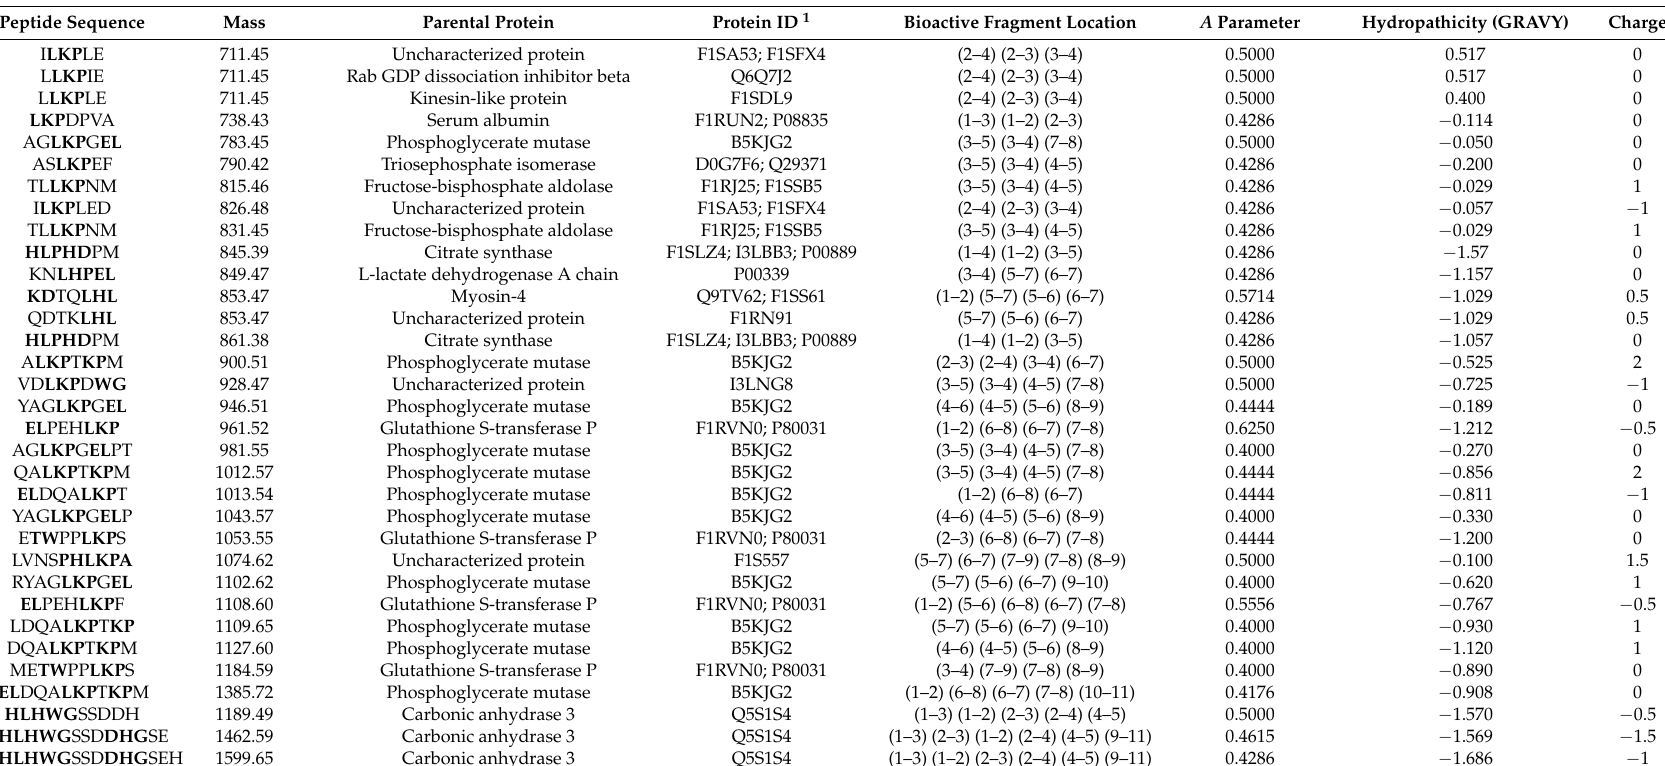
Table 7. Peptide sequences with the highest antiradical properties obtained after digestion and simulated adsorption of dry-cured pork loin after 180 days of aging. Peptide